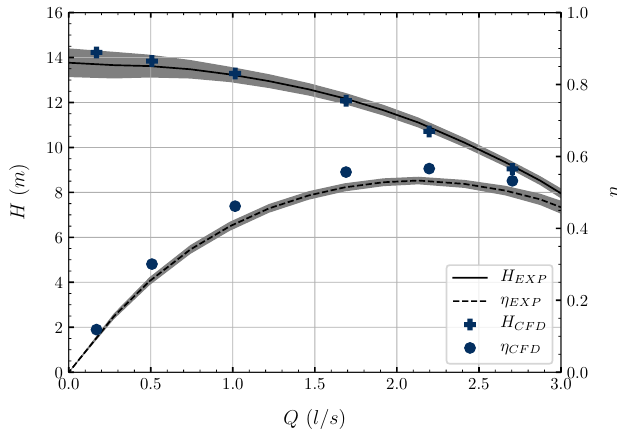
Figure 7. Head and efficiency as a function of the flow rate for Case